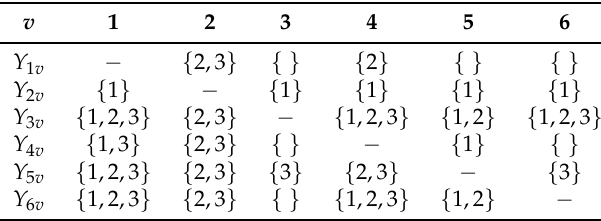
Table 5. Tabular representation of 3HF concordance